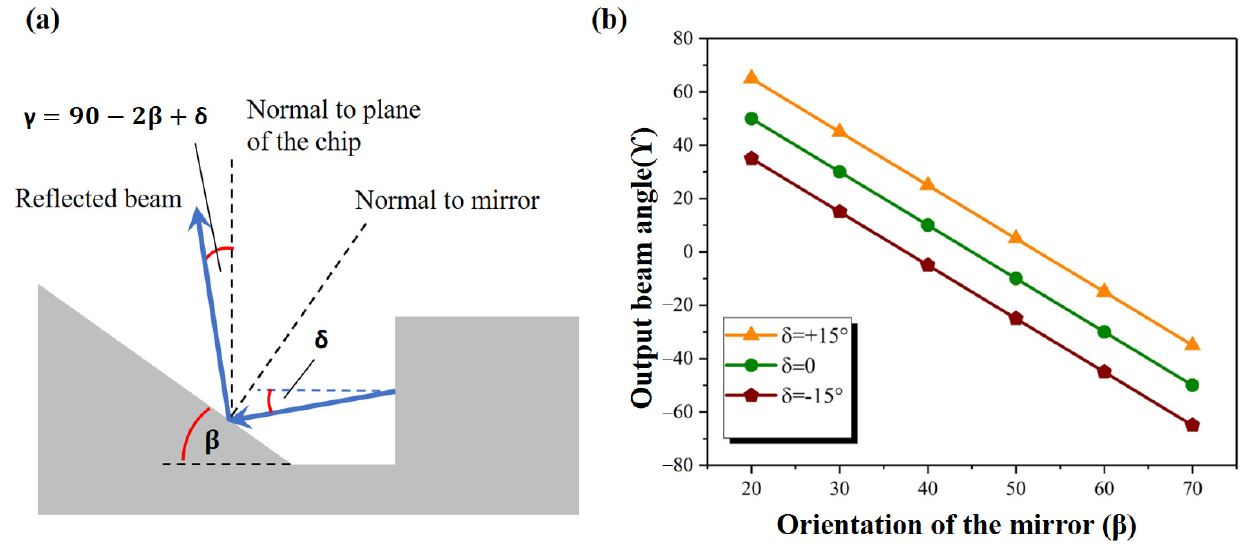
Figure 11. ( a , b ). Scheme of how theoretically the output beam angles are computed with respect to the various orientations ( β ) of the mirror. the various orientations ( β ) of the